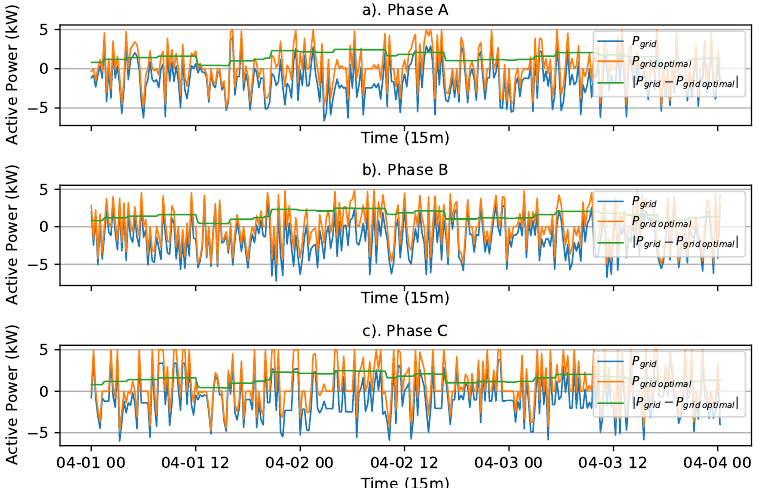
Figure 7. Per phase active powers at point of common coupling, grid optimal schedule and absolute difference between them at Bus